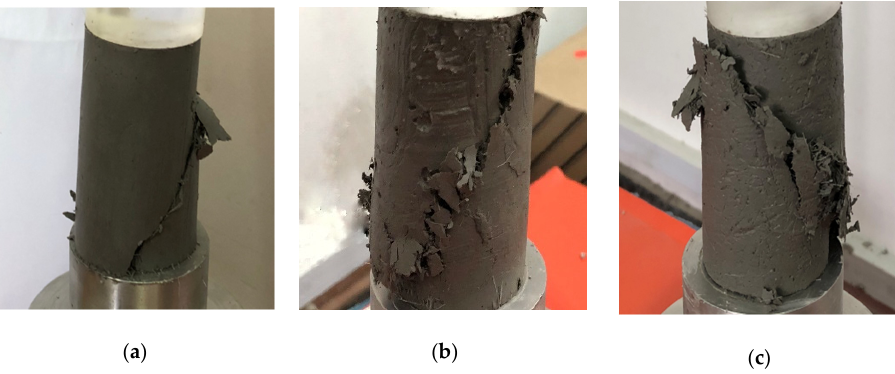
Figure 8. Failure pattern of PCC after UCC test under various freeze–thaw cycles. ( a ) 0 cycle; ( b ) 5 cycles; ( c ) 15 cycles.